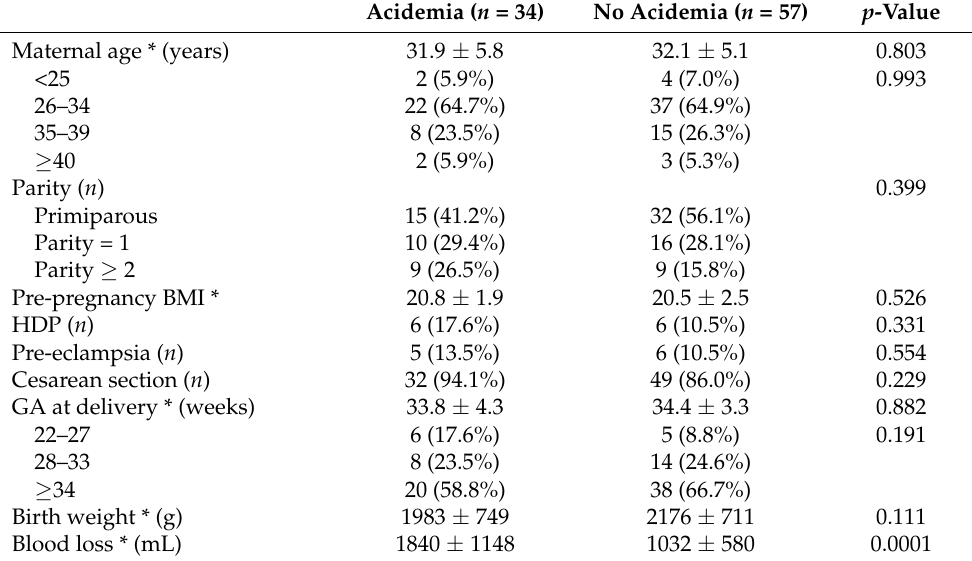
Table 1. Demographics and obstetrical characteristics of the study participants.